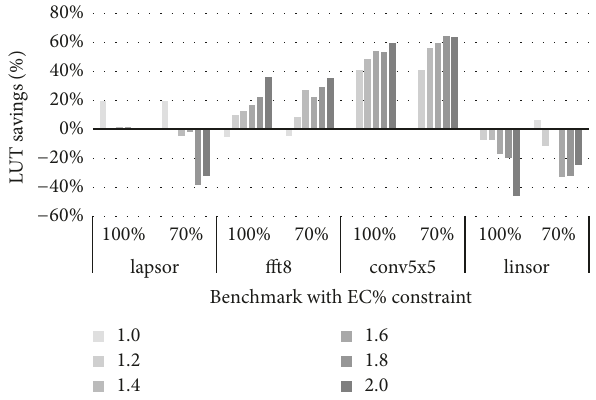
Figure 7: Resource savings of FD-FTA heuristic under different normalized latency constraints for selected benchmarks and EC% constraints when compared to the previous